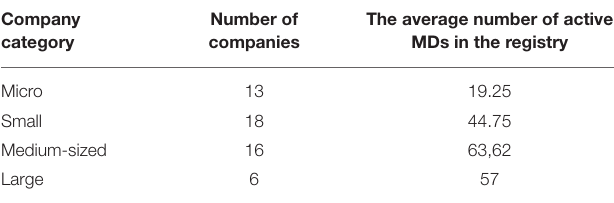
TABLE 1 | Number of MD manufacturers by size of company. Company